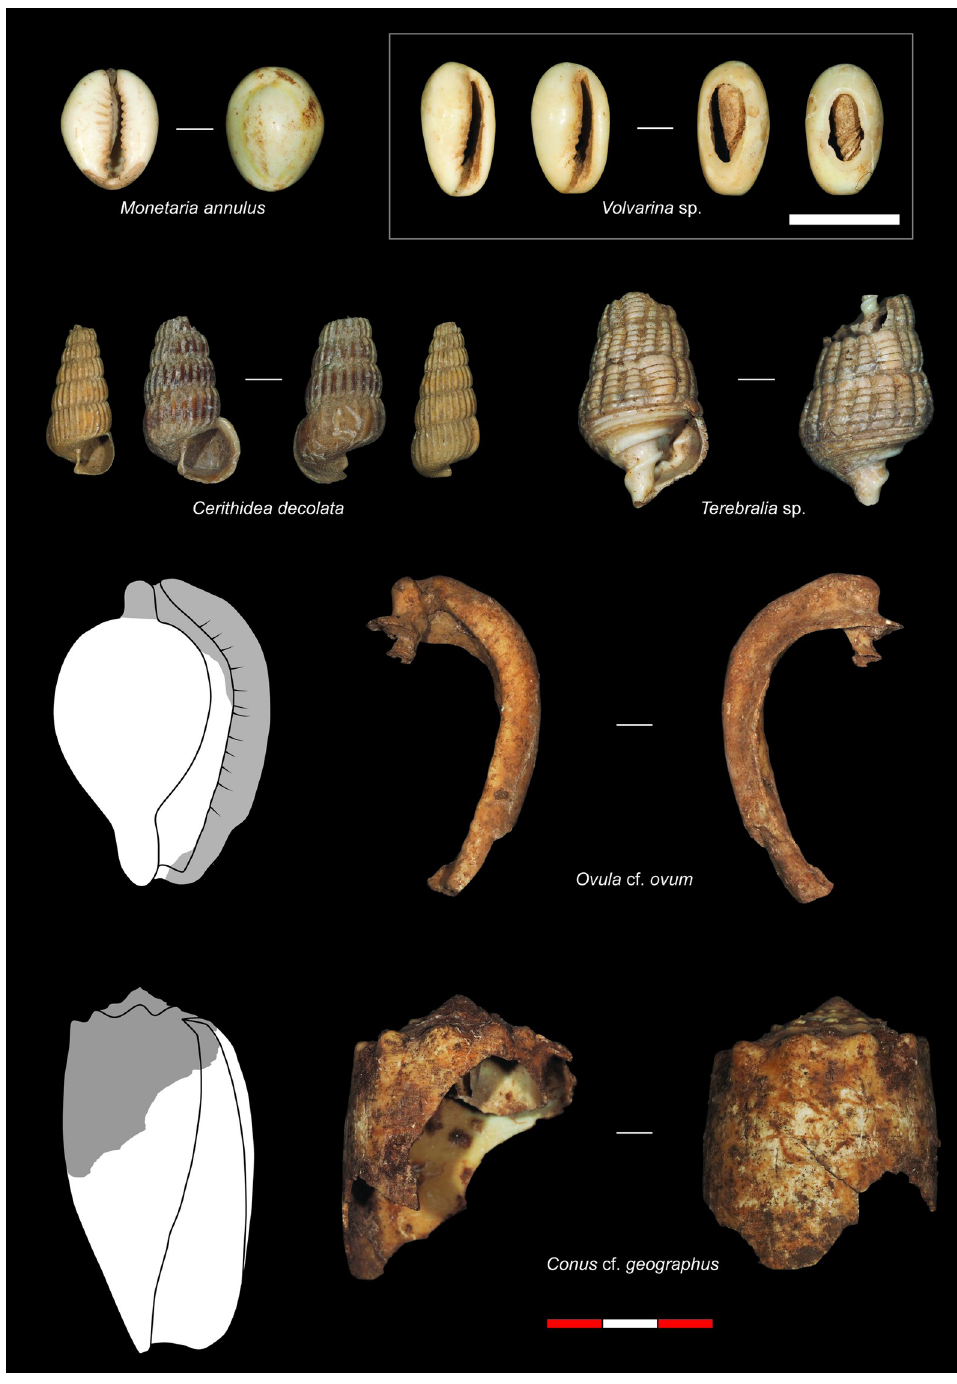
Fig 6. Examples of the subsistence and symbolic marine gastropod taxa recovered from